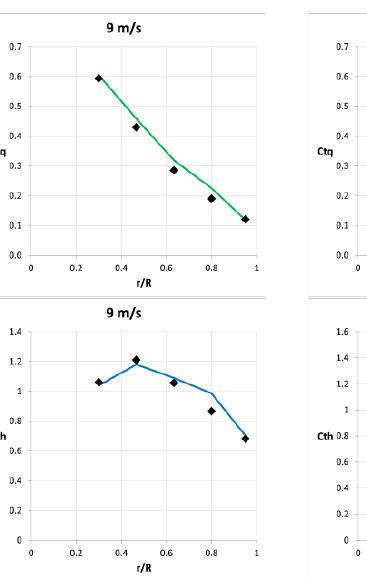
Figure 16. Blade spanwise distributions of torque coefficients (first row, Ctq) and thrust coefficients (second row, Cth) vs. data derived from measurements between 9 and 12 m/s wind velocities. Experimental data is represented as black squares and numerical data is drawn green (Ctq) and blue (Cth) curves.